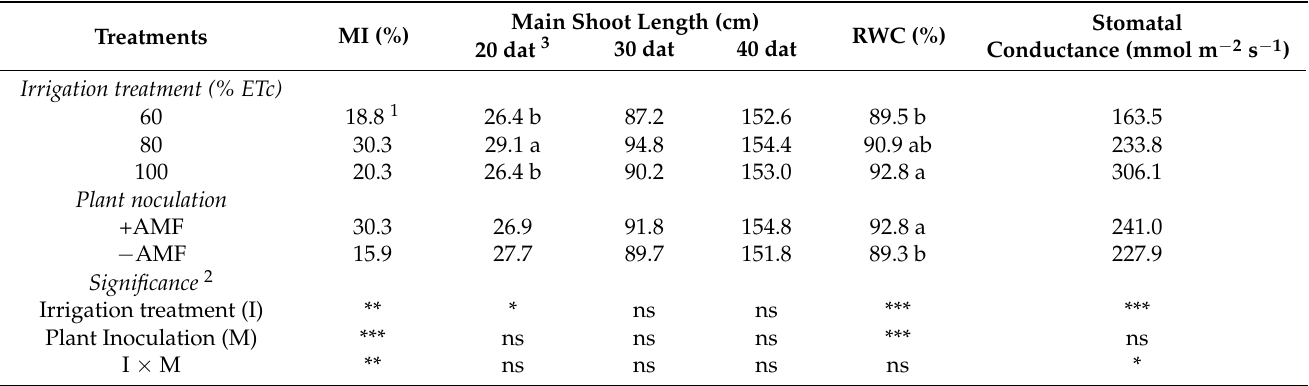
Table 2. Effect of irrigation treatments and plant inoculation with arbuscular mycorrhizal fungi (AMF) on the mycorrhizal index (MI), main shoot length, leaf relative water content (RWC), and stomatal conductance of melon plants during two years of experiments.